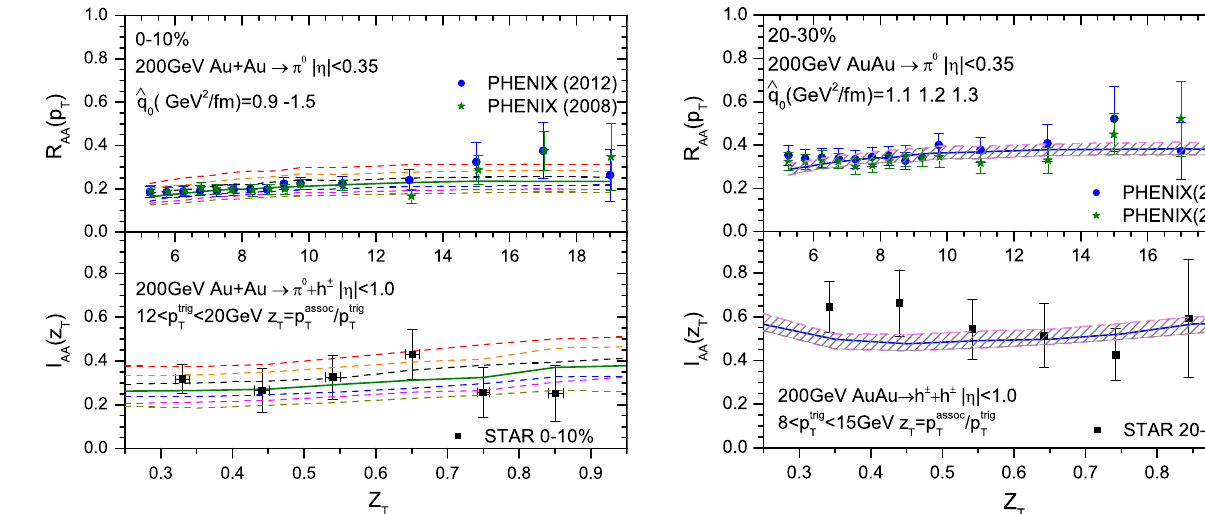
√ s NN = 0 . 2 TeV at RHIC